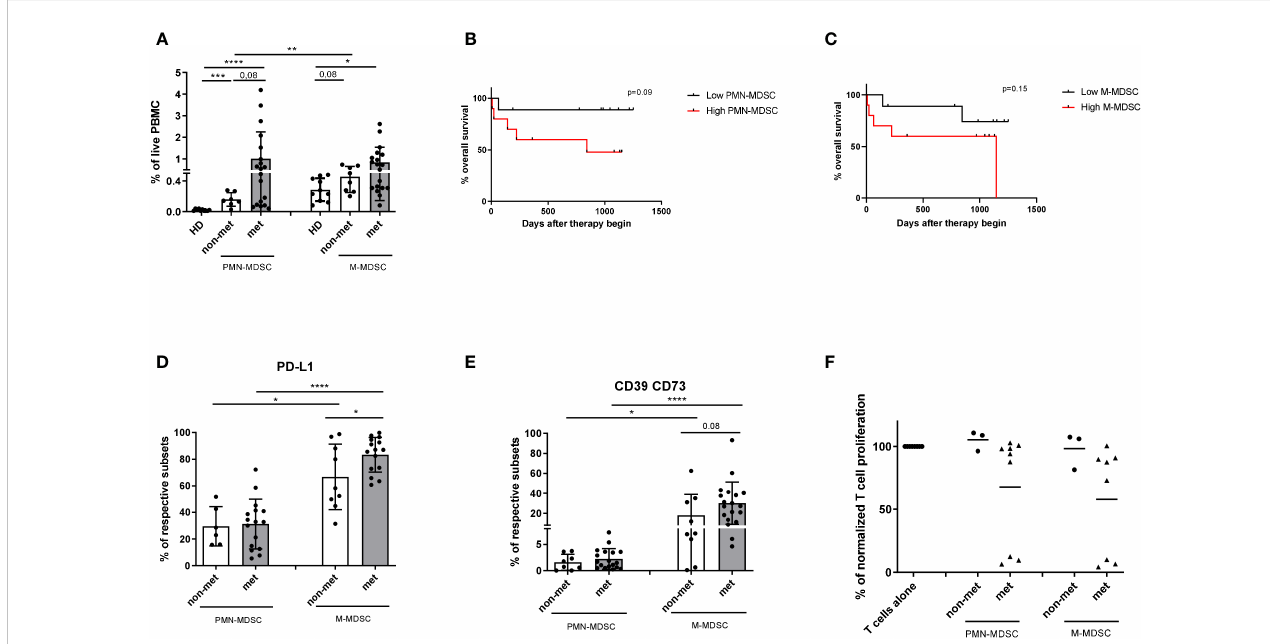
FIGURE 2 Characteristics of PMN- and M-MDSC from melanoma patients before ICI therapy. PBMCs were isolated from the peripheral blood of melanoma patients and HD. MDSC and their counterparts in HD were assessed by fl ow cytometry. (A) The results in metastatic (n=19) and non-metastatic (n=8) patients as well as their counterparts in HD (n=10) are presented as the percentage of HLA-DR low/ − CD33 dim CD66b + Lin − PMN- and HLA-DR low/ − CD33 high CD14 + M-MDSC among live PBMC. (B) OS of metastatic melanoma patients with high (>0.54% of live PBMC; n=10) and low (<0.54%; n=9) PMN-MDSC frequencies at the baseline is shown as a Kaplan-Meier curve. (C) OS of metastatic melanoma patients with high (>0.73%; n=10) and low (<0.73%; n=9) M-MDSC frequencies at the baseline is shown as a Kaplan-Meier curve. (D, E) Expression of PD-L1 and ectoenzymes CD39 and CD73 on PMN- and M-MDSC from metastatic and non-metastatic patients was shown as the percentage of PD-L1 + cells (D) or CD39 + CD73 + cells (E) among the respective MDSC subset. (F) Immunosuppressive capacity of PMN- and M-MDSC was determined upon the co-culture with activated CD3 T cells labeled with CP-Dye405. After 96 h of incubation, T cell proliferation was assessed by CP-Dye405 dilution measured by fl ow cytometry. Cumulative data for T cell proliferation are presented as the percentage of divided T cells normalized (norm.) to the respective control of stimulated T cells alone (n=3-8). * P < 0.05, ** P < 0.01, *** P < 0.001, **** P <